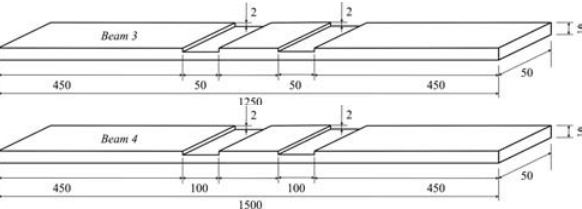
Fig 5. Geometry and dimensions of the test beams